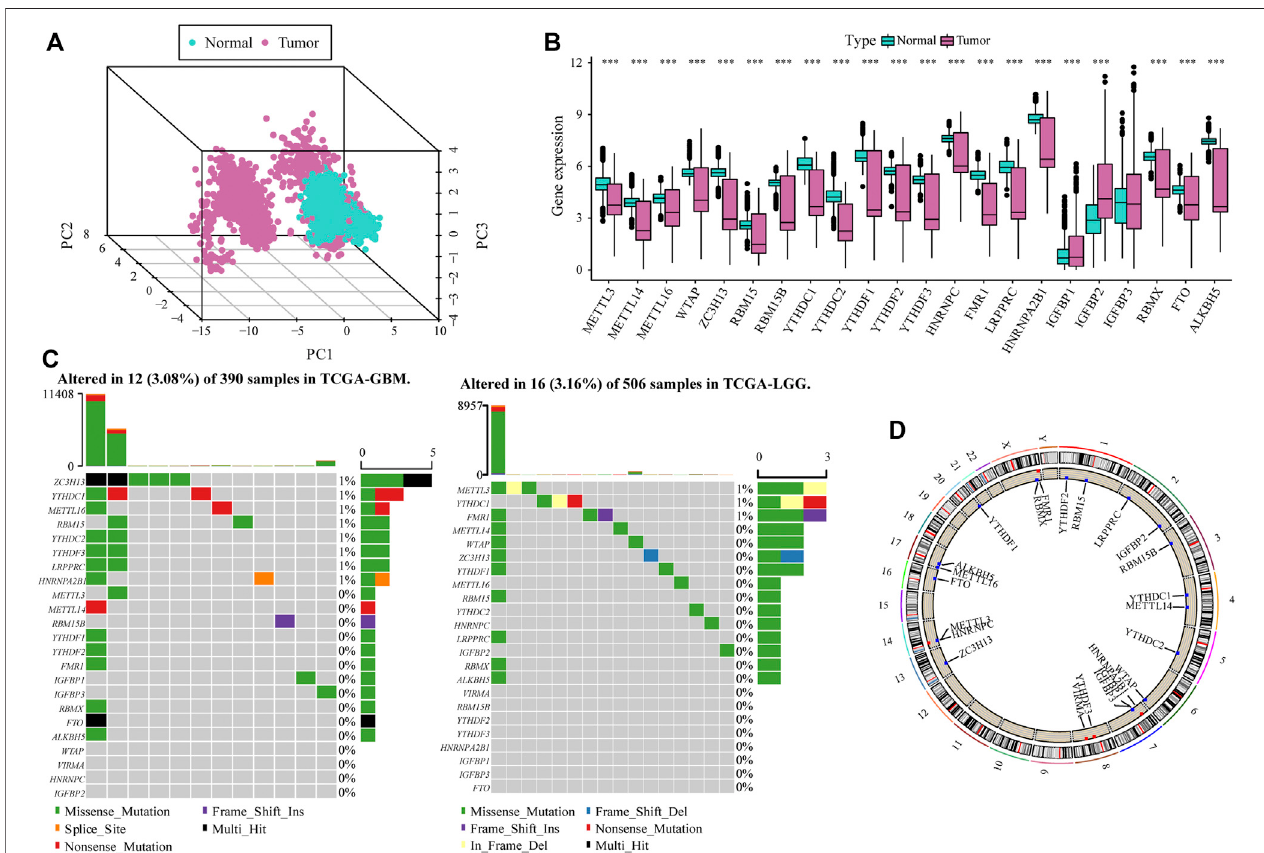
FIGURE 1 | Overall m6A-related gene expression in glioma patients. (A) PCA shows that there are certain differences in the overall levels of m6A-related genes in glioma and normal brain tissue in the The Cancer Genome Atlas (TCGA), CGGA, and GTEx datasets; (B) Most m6A-related genes were expressed differently in glioma tissuecomparedwiththenormalbraintissue; (C) m6A-relatedgenemutationmapinTCGA-gliomapatients.Thesamplesaresortedaccordingtotheburdenofsomatic non-synonymous mutations, and the genes are sorted by mutation frequency. Different colors indicate different mutation types; the upper section of the legend shows mutation load; (D) Differential copy number variation of m6A-related genes on 23 chromosomes in TCGA glioma